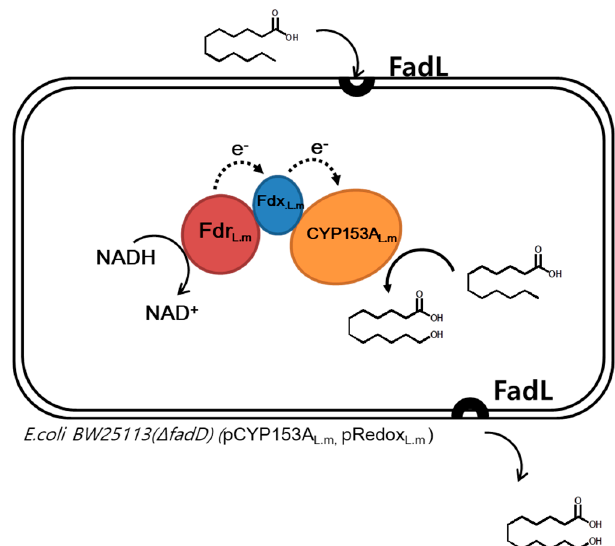
Figure 1. Synthesis of ω -hydroxydodecanoic acid ( ω -OHDDA) from dodecanoic acid (DDA) using CYP153A three-component system.